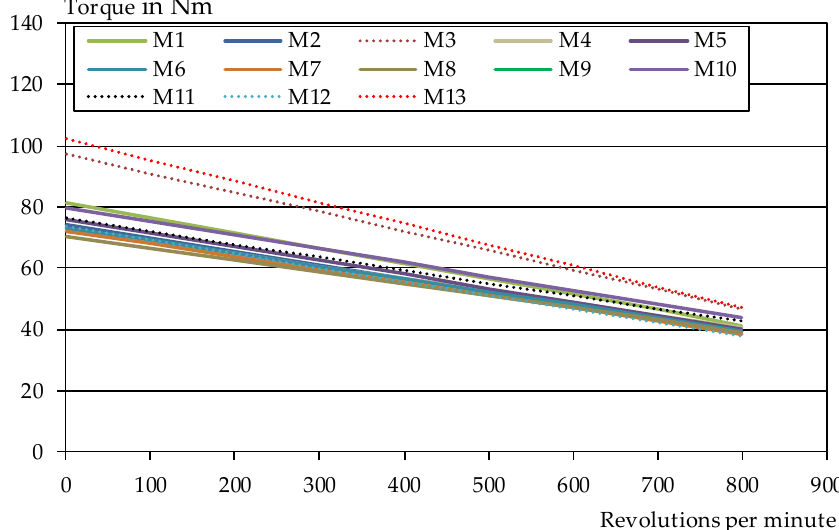
Figure 9. Determined flow curves from mixer data for all mixtures. Non-extrudable mixtures are shown as dotted lines.